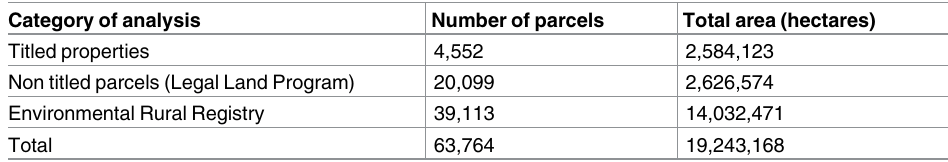
Table 2. Summary of non-overlapping parcels used in CRA